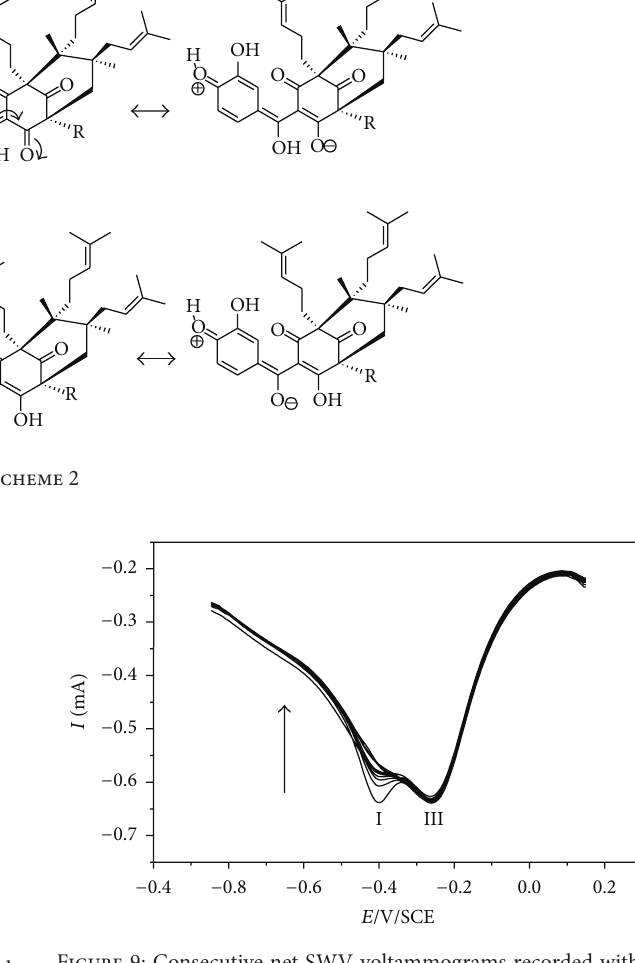
Figure 8: Square Wave Voltammetry at thinfilm electrode recorded in contact with aqueous medium at pH = 0.46 (a), 0.76 (b) and 1.00 (c). The parameters of the potential modulation are the same as for Figure 5.